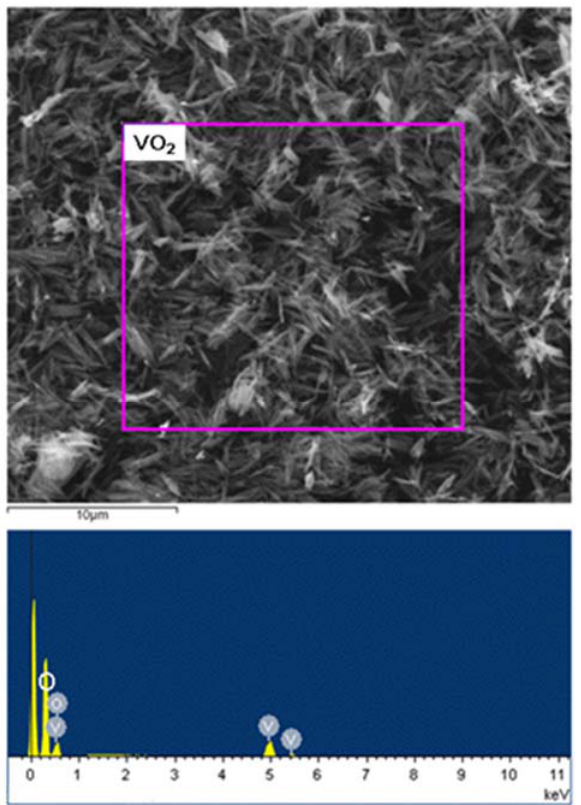
Figure 4. SEM image and EDS spectrum of the VO 2 (B) nanobelts.